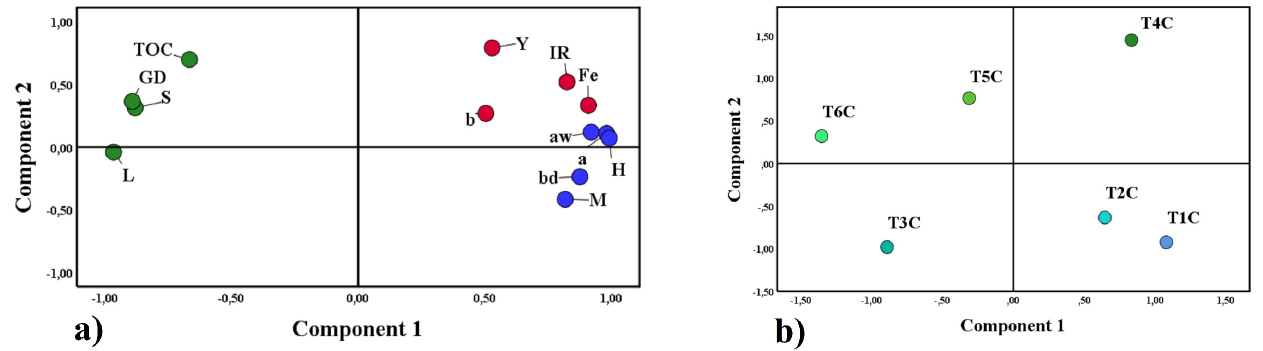
Figure 10. Principal component analysis, properties studied ( a ), and treatments ( b ).